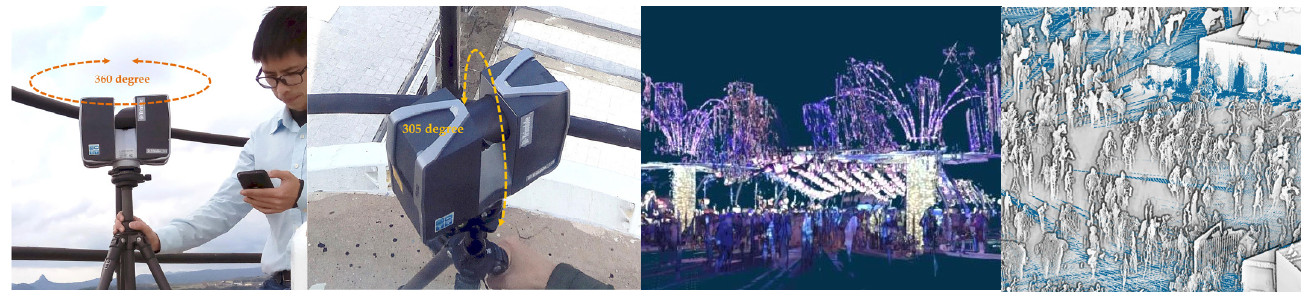
Figure 3. Faro Focus 3D ® laser scanner and field scan.